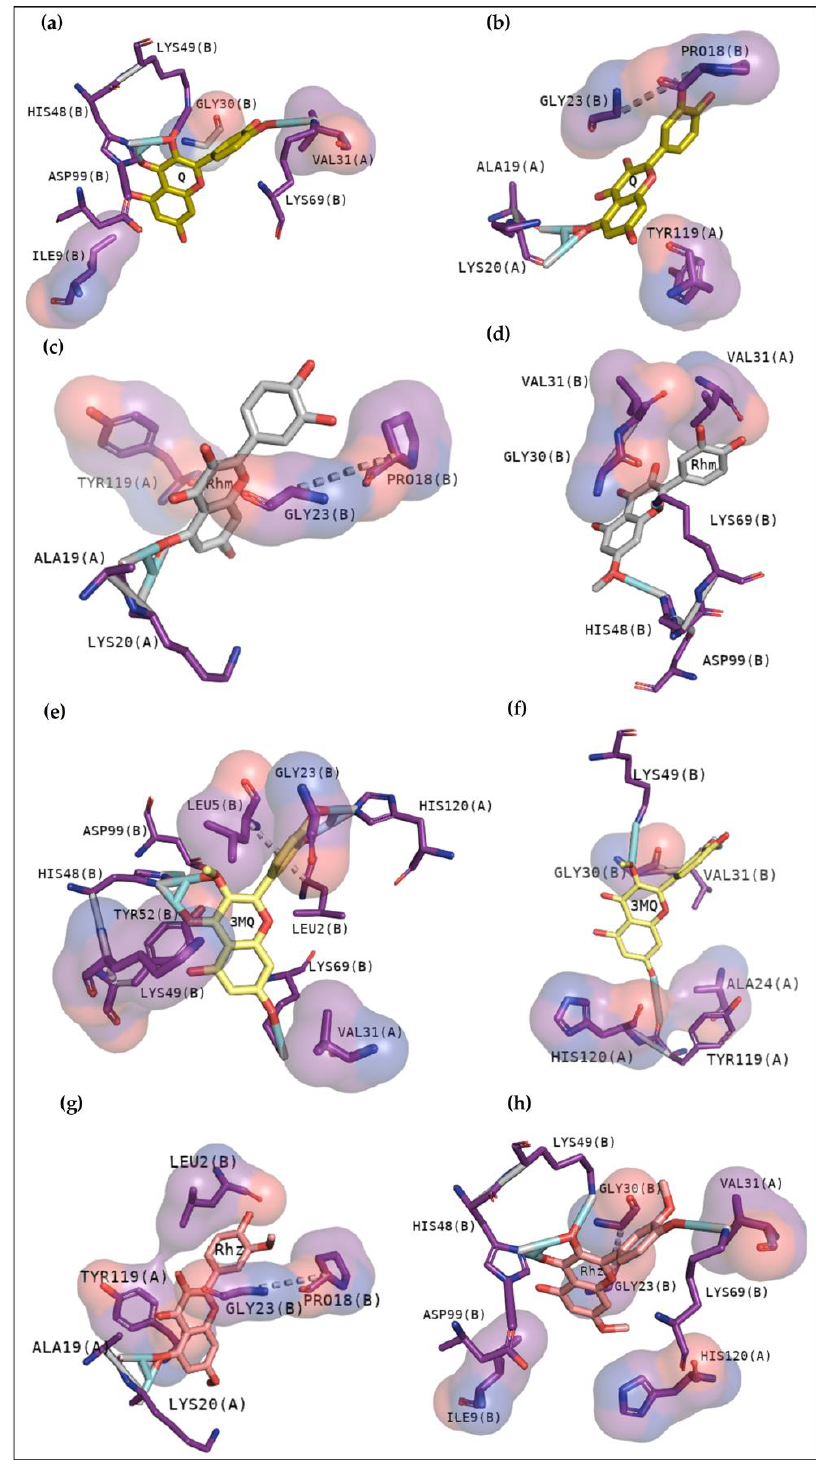
Figure 6. Docking results of BthTX-I with Q in the first cluster ( a ) and the second cluster ( b ), revealing great interactions with His48, Lys49 and Lys69. BthTX-I-Rhm anchoring, emphasizing Lys20, Tyr119 in the first cluster ( c ) and His48, Lys49 and Gly30 in the second ( d ). 3MQ exhibit in the first image ( e ) to anchor strongly with His48 plus Lys69, and in the second with Gly30, Lys49 and the C-terminal region ( f ). Lys20 and Tyr 119 also appears anchoring with Rhz ( g ) and Lys49 and His48 are the strong interactions in the second cluster ( h ). Hydrogen bonds are represented by blue cylinders, and hydrophobic contacts by purple and red colors around the